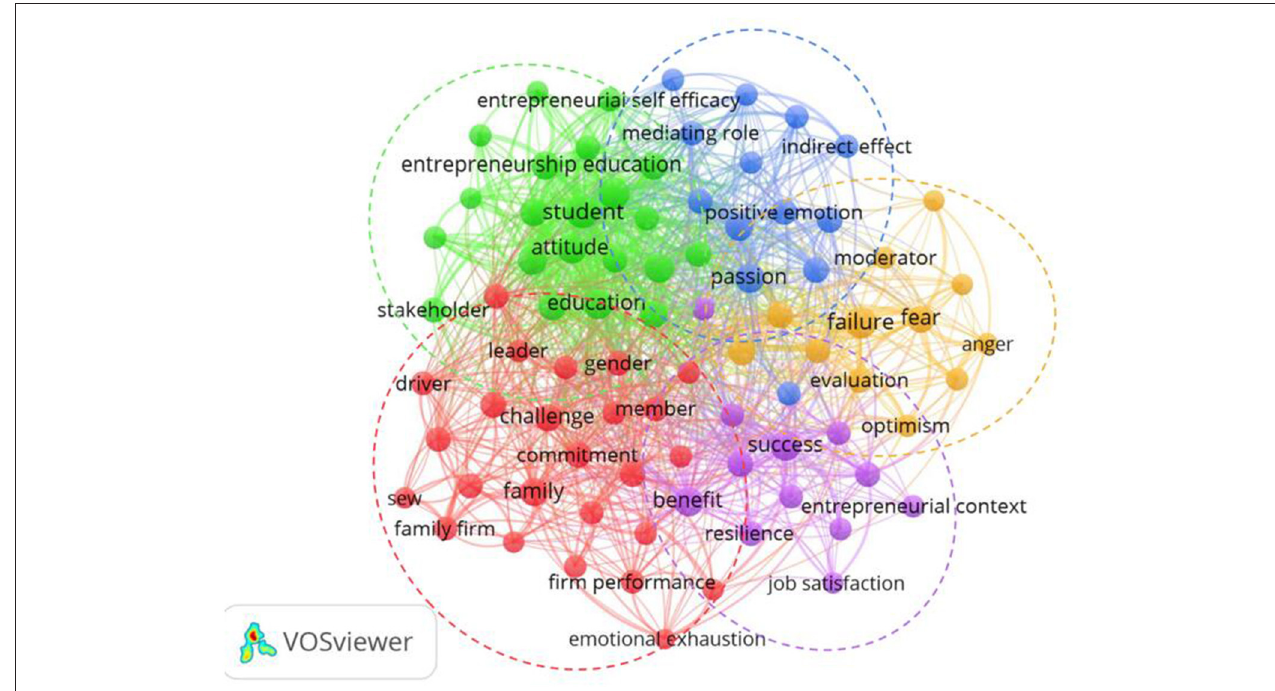
FIGURE 3 | Research hotspot